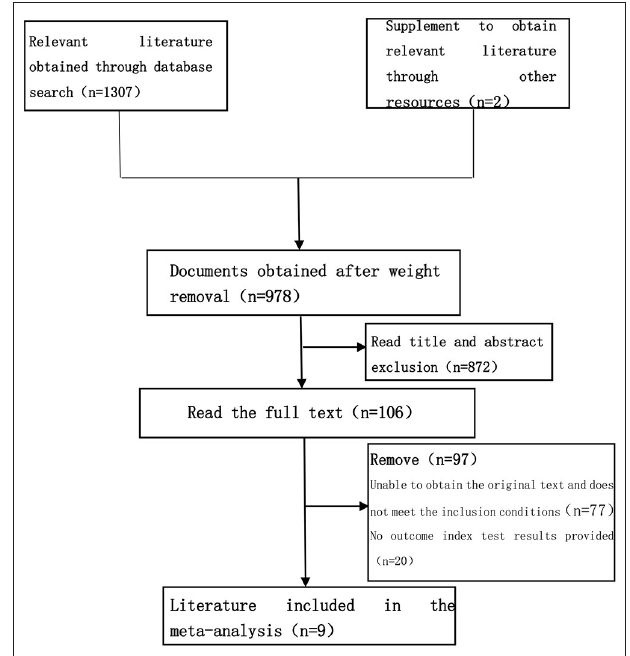
FIGURE 1 | Document screening flow